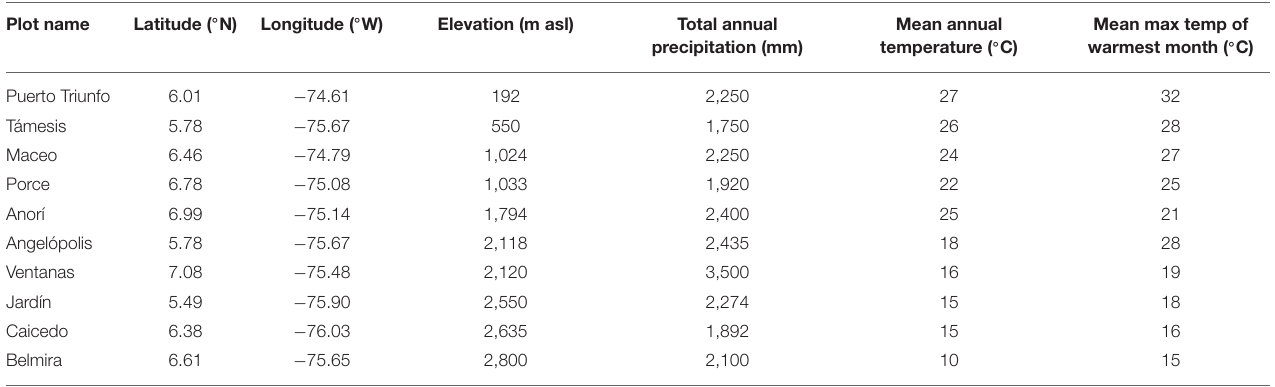
TABLE 1 | Location and climate of study plots. Plot name Latitude ( ◦ N) Longitude ( ◦ W) Elevation (m asl) Total annual